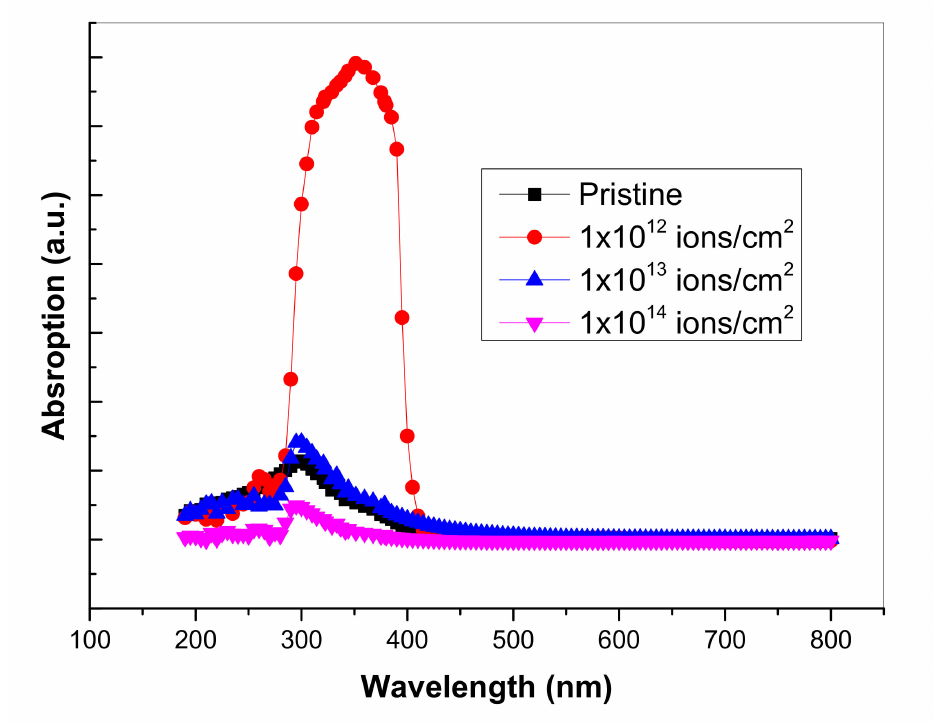
Figure 8. UV-vis absorption spectra for pristine and Cu + implanted